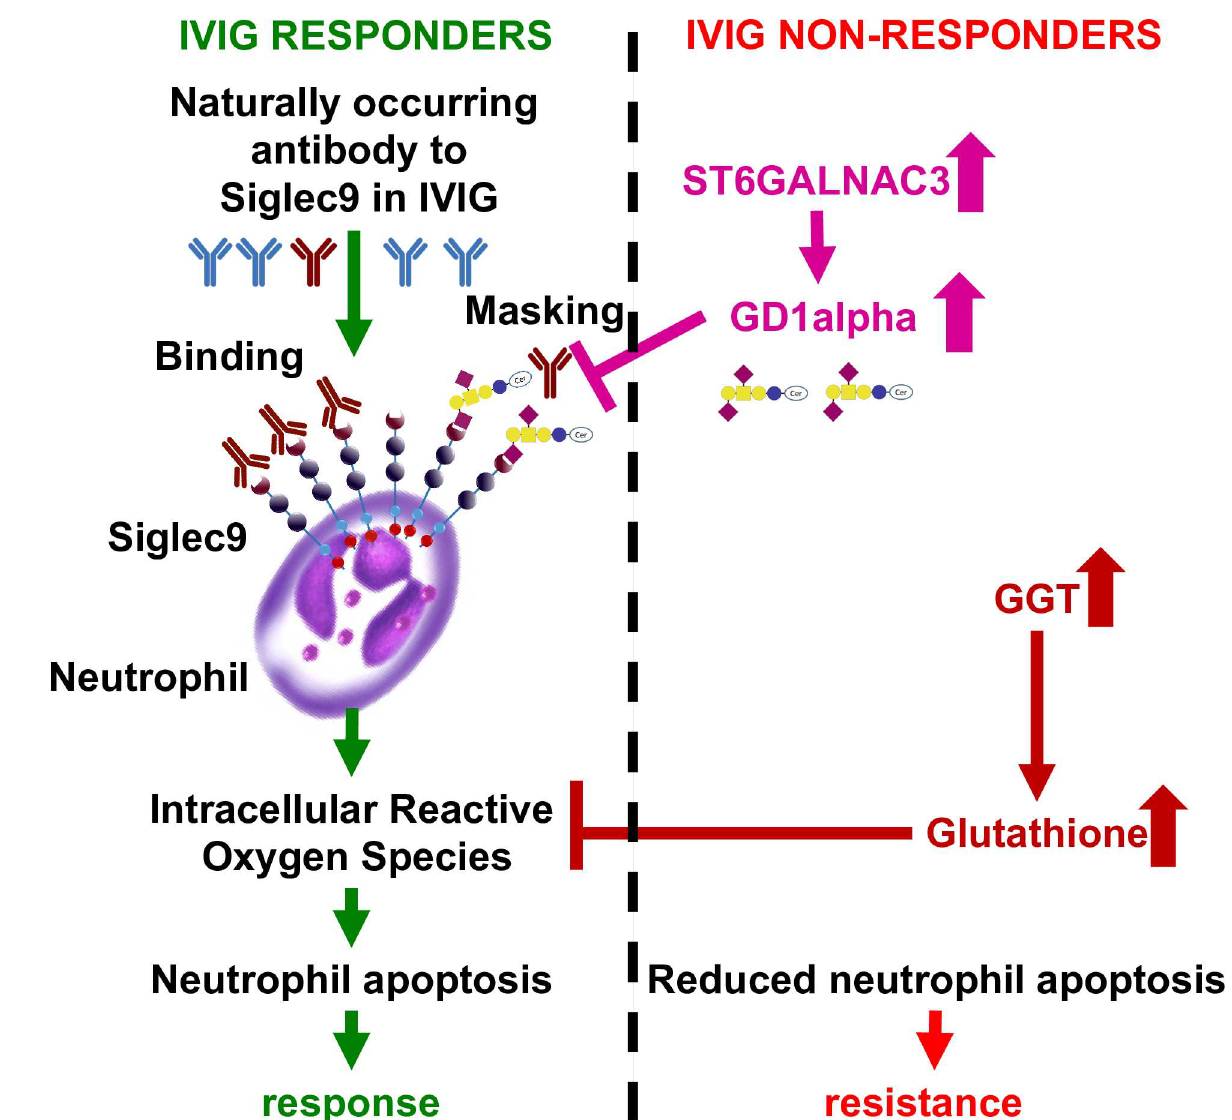
Fig 5. Hypothesis of the underlying biology of IVIG responsiveness involving neutrophils, siglec-9, ST6GALNAC3, and